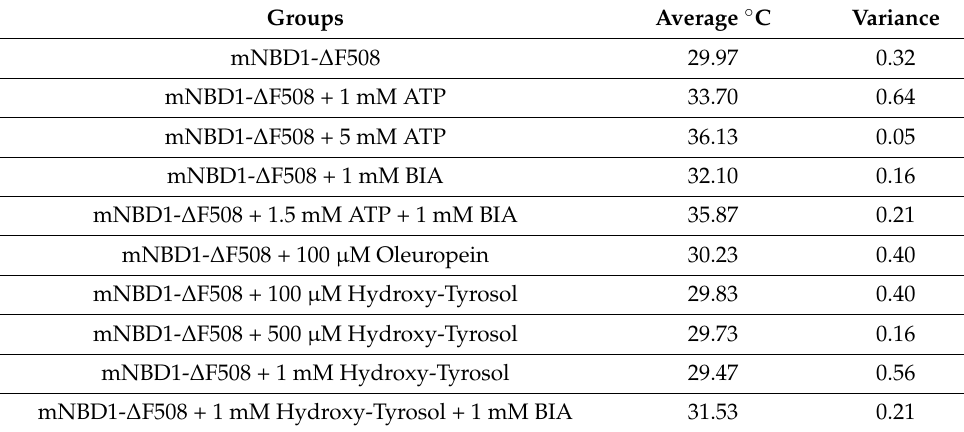
Table 1. Summary of DSF experiments of mNBD1- ∆ F508 with/without